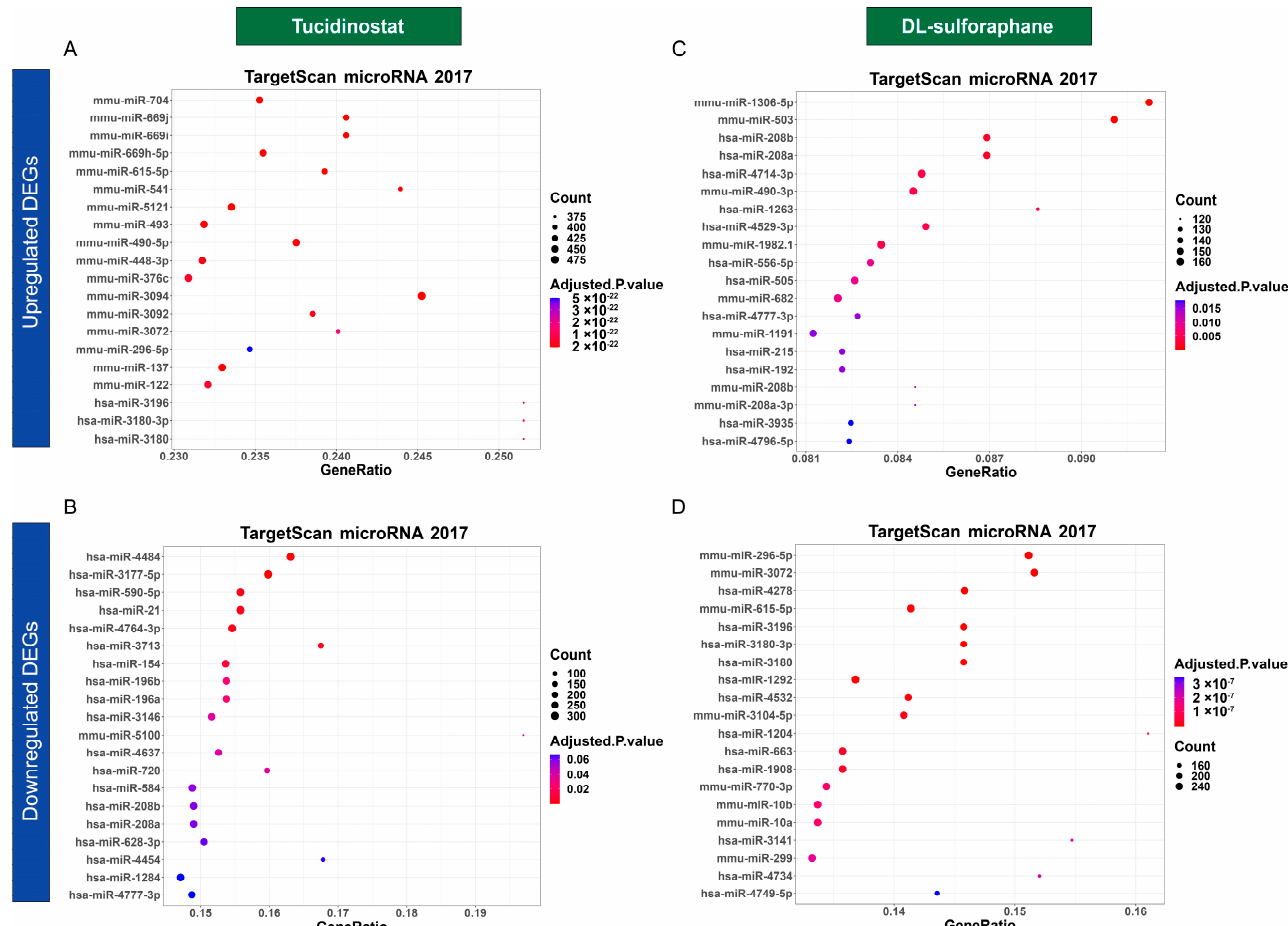
Figure 12. MicroRNAs enrichment analysis. The dot plots showed the top twenty enrichment Terms for microRNAs associated with up DEGs ( A ) and down DEGs ( B ) in response to Tucidinostat treatment. ( C ) MicroRNAs associated with up DEGs in response to DL-sulforaphane treatment. ( D ) MicroRNAs associated with down DEGs in response to DL-sulforaphane treatment.